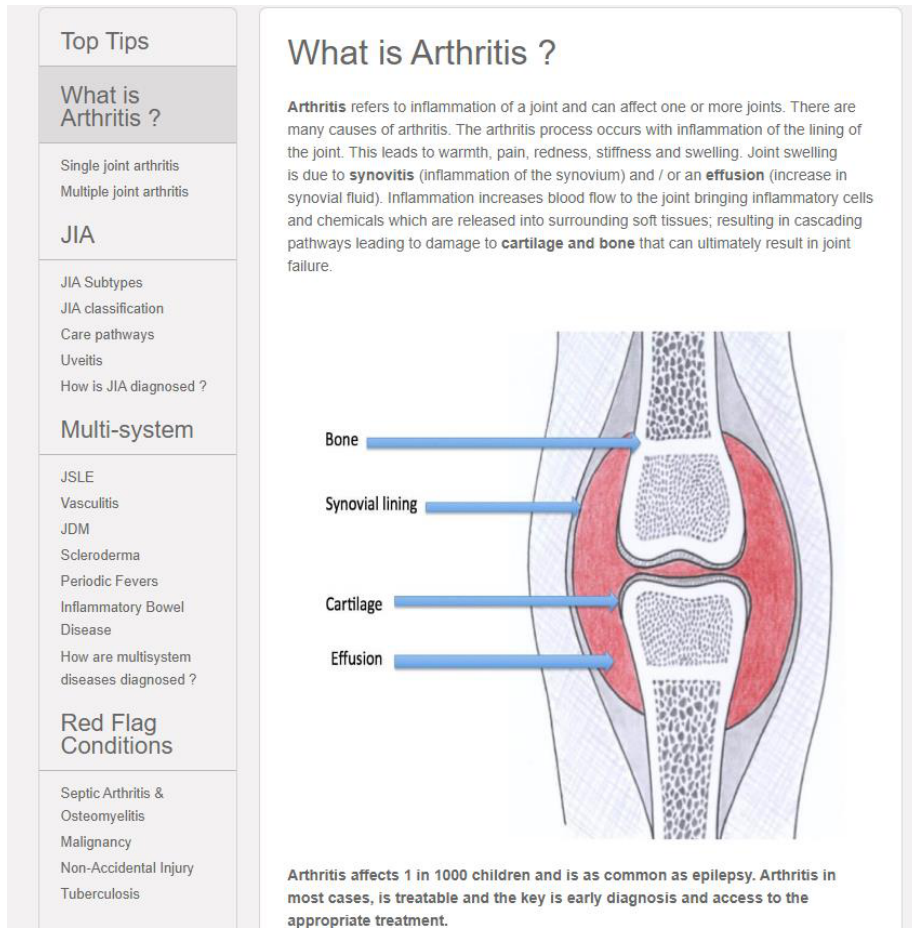
Figure 2. Example of novice to expert design.